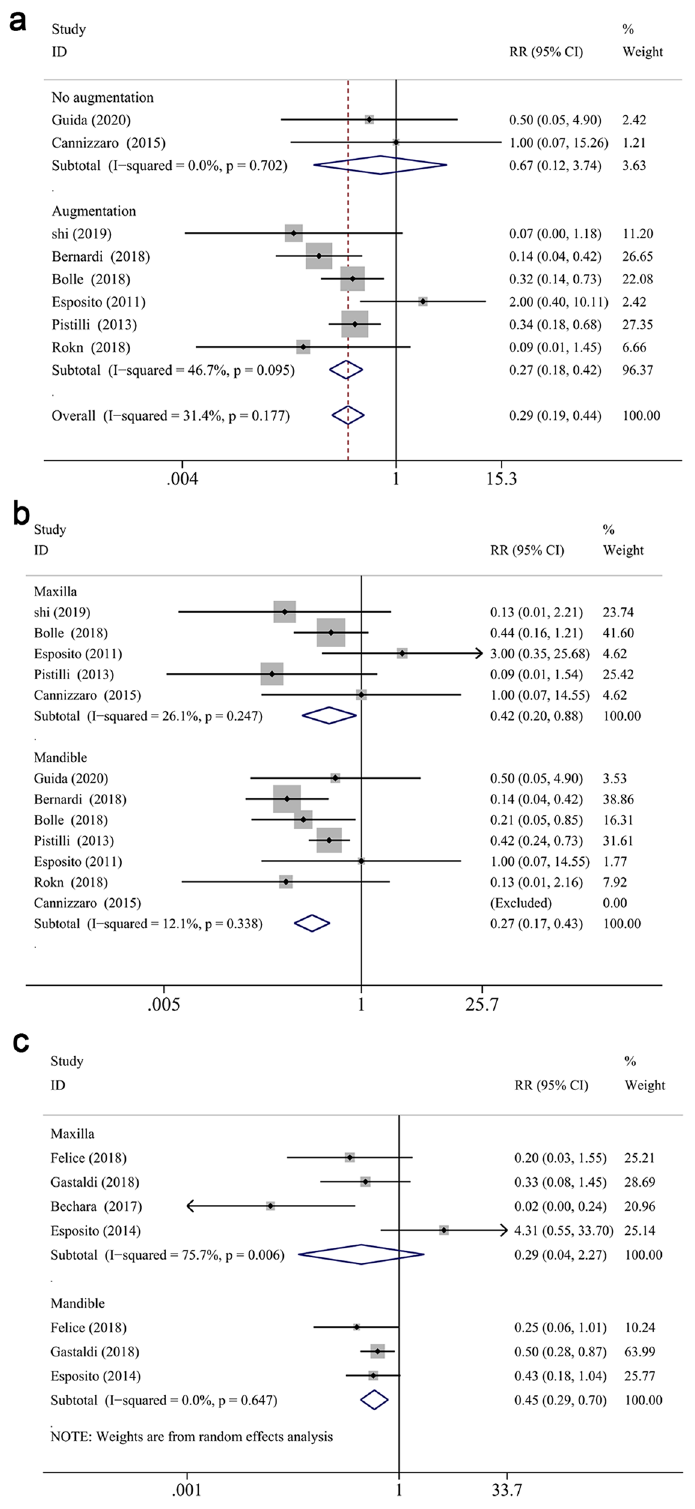
Figure 11. Subgroup analyses for the effects of augmentation on biological complication rate at 1-year ( a ). Subgroup analyses of maxilla/mandible on biological complication rate at 1-year ( b ) and 3-years ( c ) follow-up. Mantel–Haenszel (MH)-weighted RR < 1 indicated a lower complication rate of extra-short implants than the longer